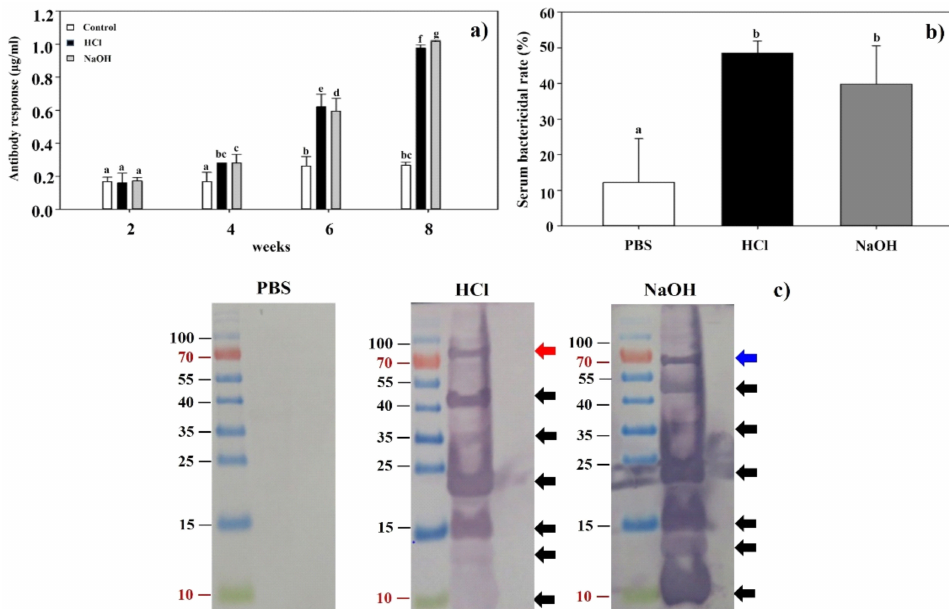
Figure 6. ( a ) The levels of IgG antibody in BALB/c mice vaccinated with LMGs were determined by indirect ELISA using Lm as an antigen. Antisera were obtained from mice in three groups (PBS- treated control, HCl-induced LMGs and NaOH-induced LMGs) at 2, 4, 6, and 8 weeks and used as an antibody. Different letters (a, b, bc, c, d, f, and g) indicate significant differences between the antibody responses of the immunized (HCl and NaOH) and non-immunized (PBS) groups ( p < 0.05). ( b ) Serum bactericidal activities of BALB/c mice subcutaneously injected with PBS, HCl-induced LMGs, and NaOH-induced LMGs, respectively. The letters (a and b) indicate significant differences between serum bactericidal activities of the immunized (HCl and NaOH) and non-immunized (PBS) groups ( p < 0.05). ( c ) Western blot analysis of total proteins extracted from Lm cells that were probed with antiserum from BALB/c mouse injected with PBS, HCl-induced LMGs, and NaOH-induced LMGs, respectively. Data were expressed as means ± standard errors of the